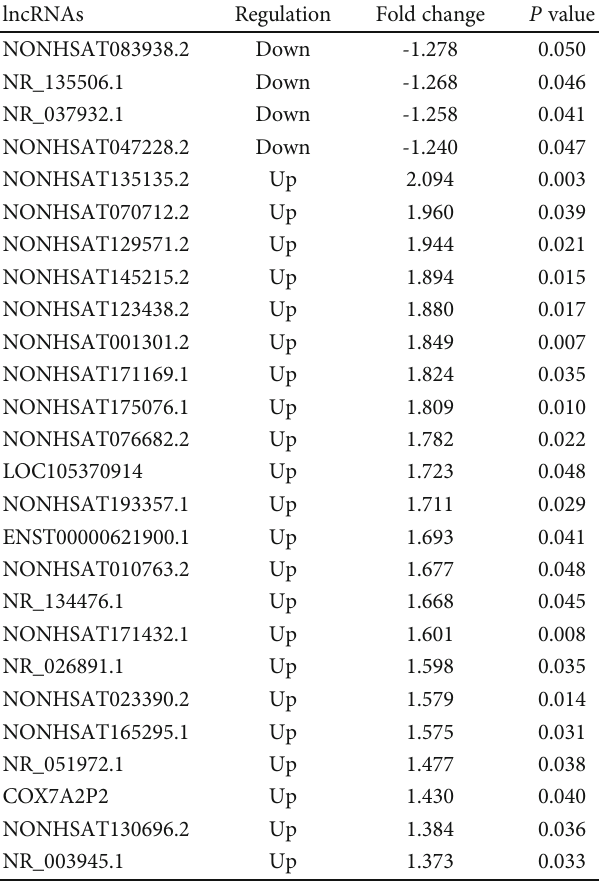
Table 1: Di ff erentially expressed lncRNAs between cirrhosis and cirrhotic HCC